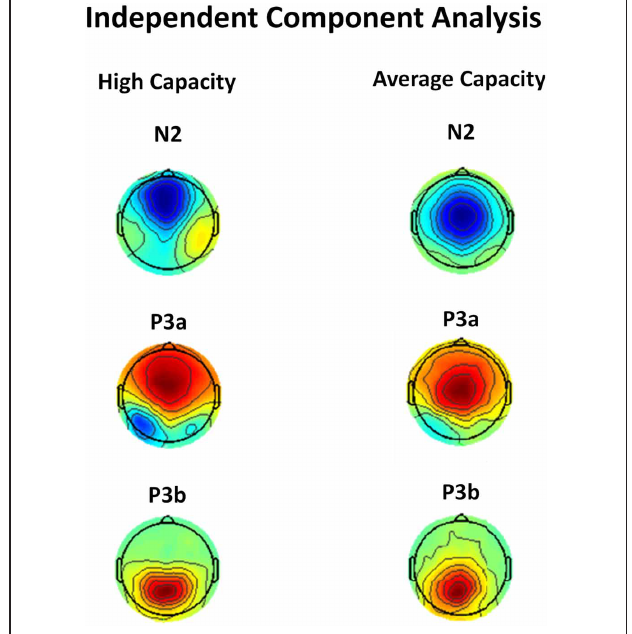
FIGURE 9 | Independent components representing the anterior N2, P3a, and P3b components in response to target stimuli for high capacity and average capacity